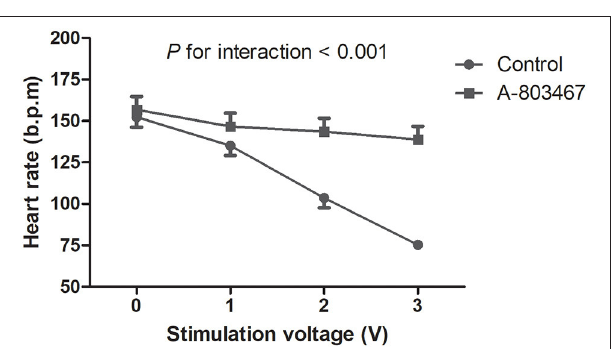
FIGURE 4 | Effects of A-803467 on the ganglionated plexi activity at 10min after local injection into the anterior right ganglionated plexi. The trend in the heart rate change with increasing stimulation voltage was significantly different between the A-803467 group and the control group.